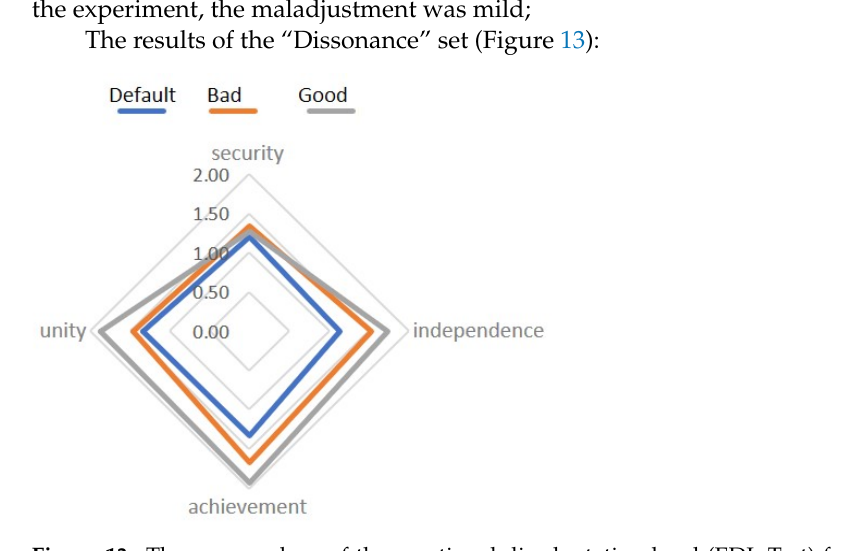
Figure 13. The mean values of the emotional disadaptation level (EDL Test) for the Dissonance complex, compared by context.